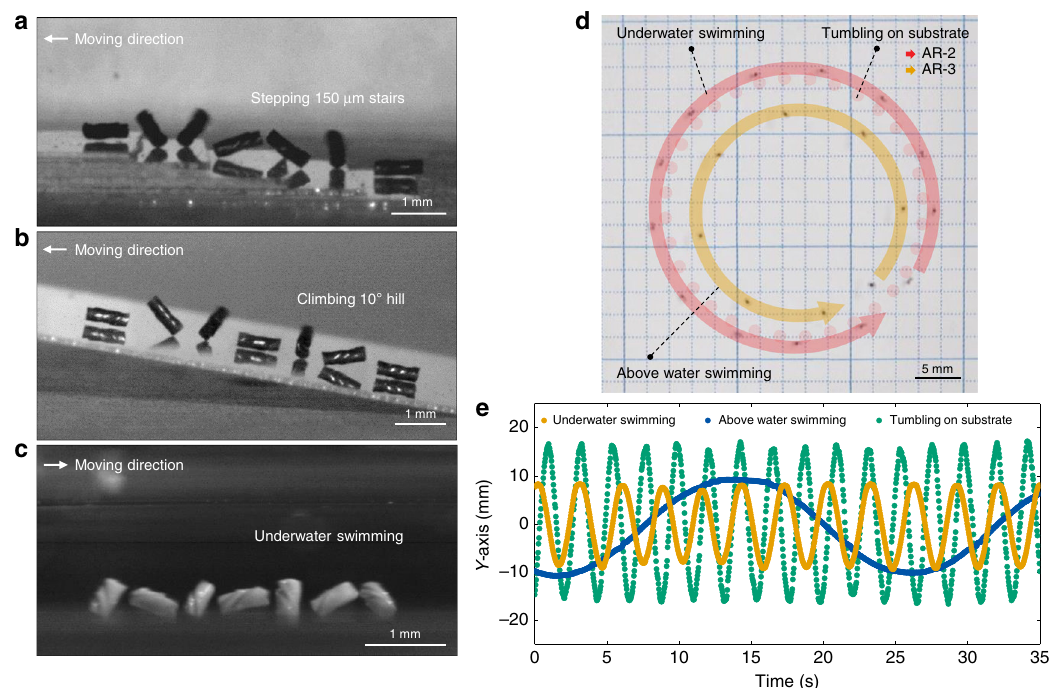
Fig. 4 Multifunctionality of 3D helical spinbots. a – c Time-lapsed images of the revolving spinbots for 0.2 s. a Stepping AR-3 at 1040 r.p.m. b AR-3 climbing uphill at 1040 r.p.m. and overcoming slips by frictional force. c Underwater swimming of AR-2 at 1420 r.p.m. d Concurrent swimming motions of underwater AR-2 with an orbital period of 4 s and above water AR-3 with an orbital period of 19 s at 1200 r.p.m. The dot line is a guide of AR-2 tumbling on substrate. e Orbital maneuver of the amphibious spinbot in the case of AR-2 at 1580